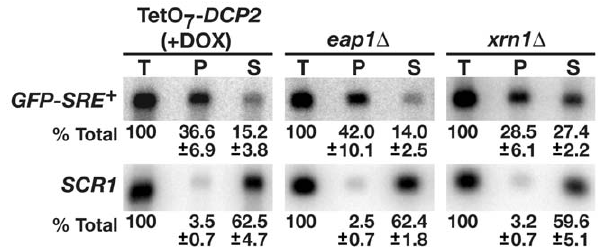
Figure 5. Eap1p stimulates transcript decapping. Total RNA was isolated from the indicated cells expressing the GFP-SRE + reporter during transcriptional pulse-chase experiments 16 min after transcrip- tional shut off with glucose. These samples were subjected to immunoprecipitation using an antibody that recognizes the 5 9 cap and equivalent amounts of RNA from starting material (T), immuno- precipitated material (P) and the supernatant from the immunopreci- pitates (S) were assayed for GFP-SRE + mRNA and SCR1 RNA levels via Northern blots. The results of three independent experiments were quantitated and the average percentage of material in each sample along with the standard deviation are indicated. Note that GFP-SRE + is significantly enriched in immunoprecipitates from both TetO 7 - DCP2 cells treated with doxycycline and eap1 D cells as determined by a t test (P , 0.01) while this is not the case in immunoprecipitates from xrn1 D cells.